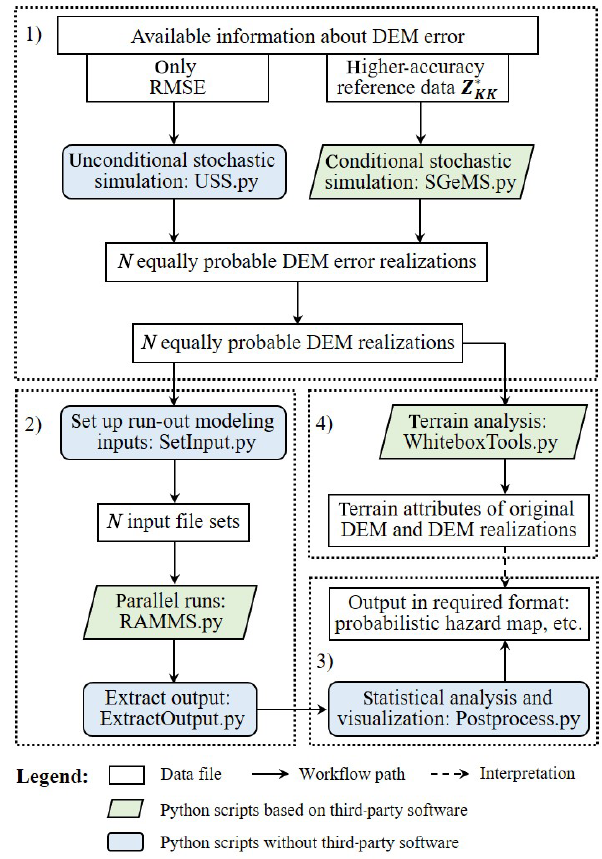
Figure 1. Computational workflow of DEM uncertainty propaga- tion in landslide run-out simulation. It is part of our PSI-slide pack- age in development that is designed for the purpose of systemati- cally investigating the impact of various sources of uncertainty on simulating gravity-driven mass movements (Kowalski et al., 2018; Zhao and Kowalski, 2018). The workflow consists of four modules: (1) DEM uncertainty representation, (2) landslide run-out model- ing, (3) statistical analysis and visualization, and (4) terrain analy-